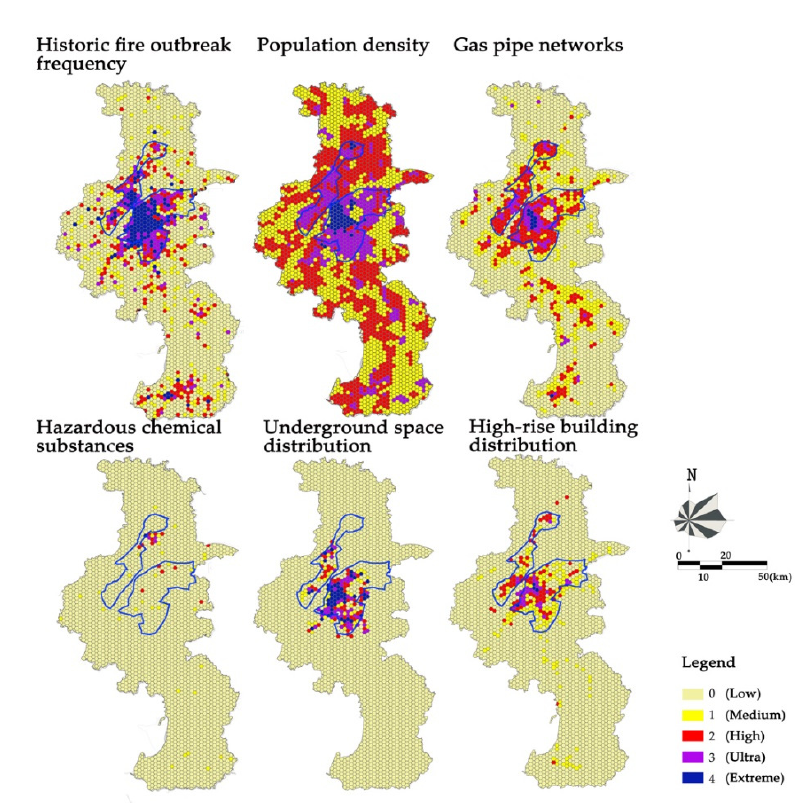
Figure 6. Evaluation factors for fire risks.